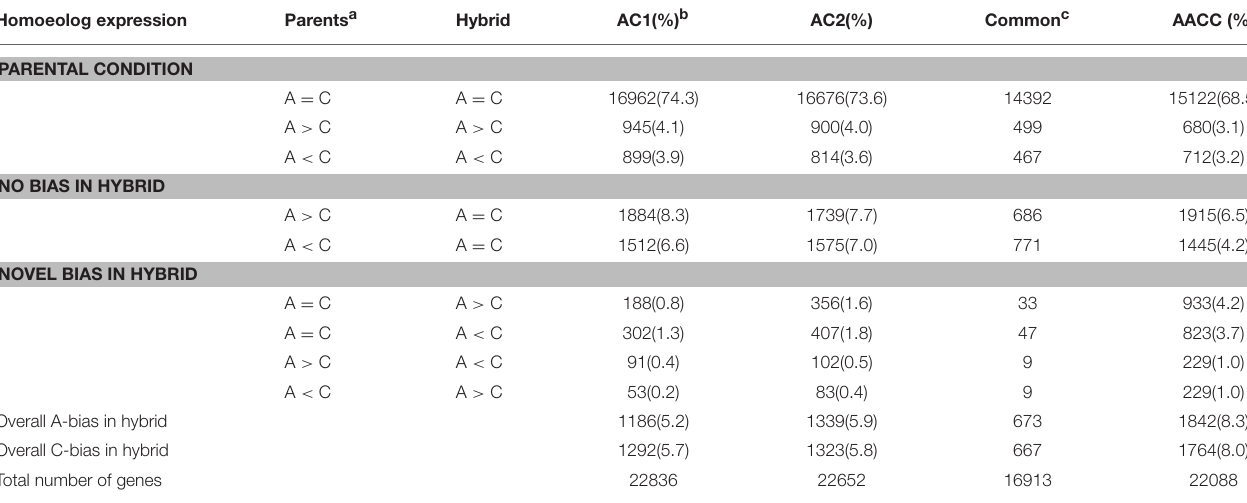
TABLE 1 | Homoeolog expression bias in the two synthetic hybrids and natural allopolyploid. Homoeolog